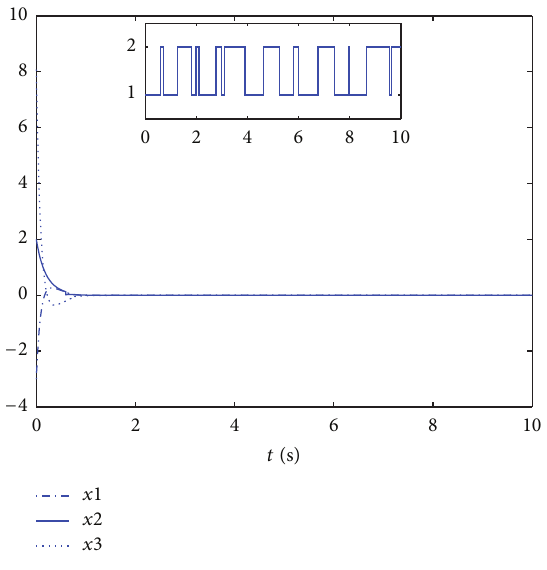
Figure 5: State trajectories of sliding mode.